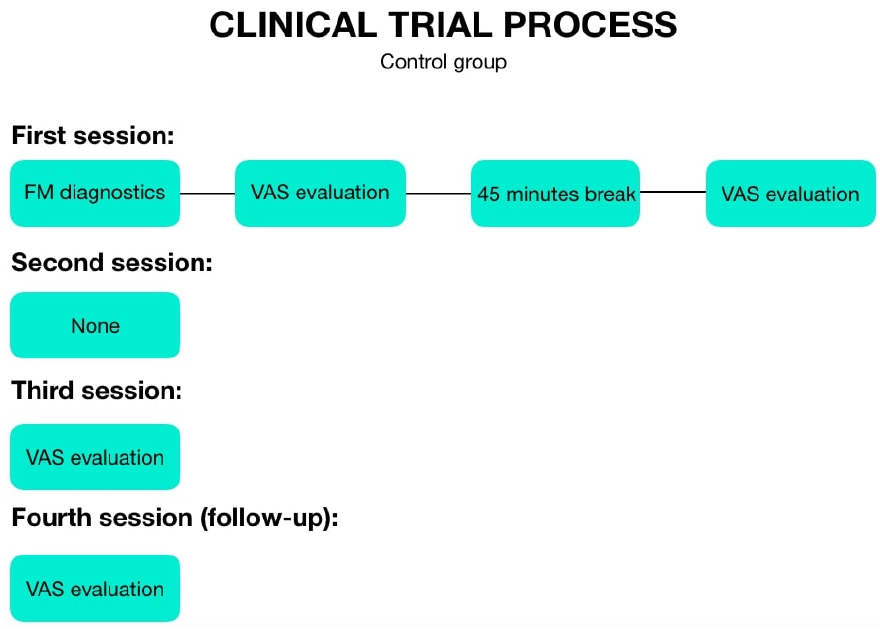
Figure 2. The examination scheme of the control group.